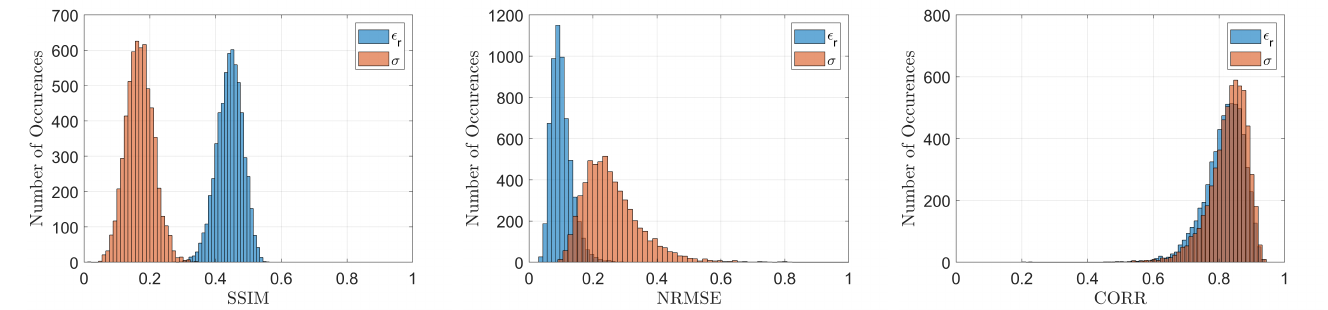
Figure 9. Histograms evaluated on the whole testing population for the adopted